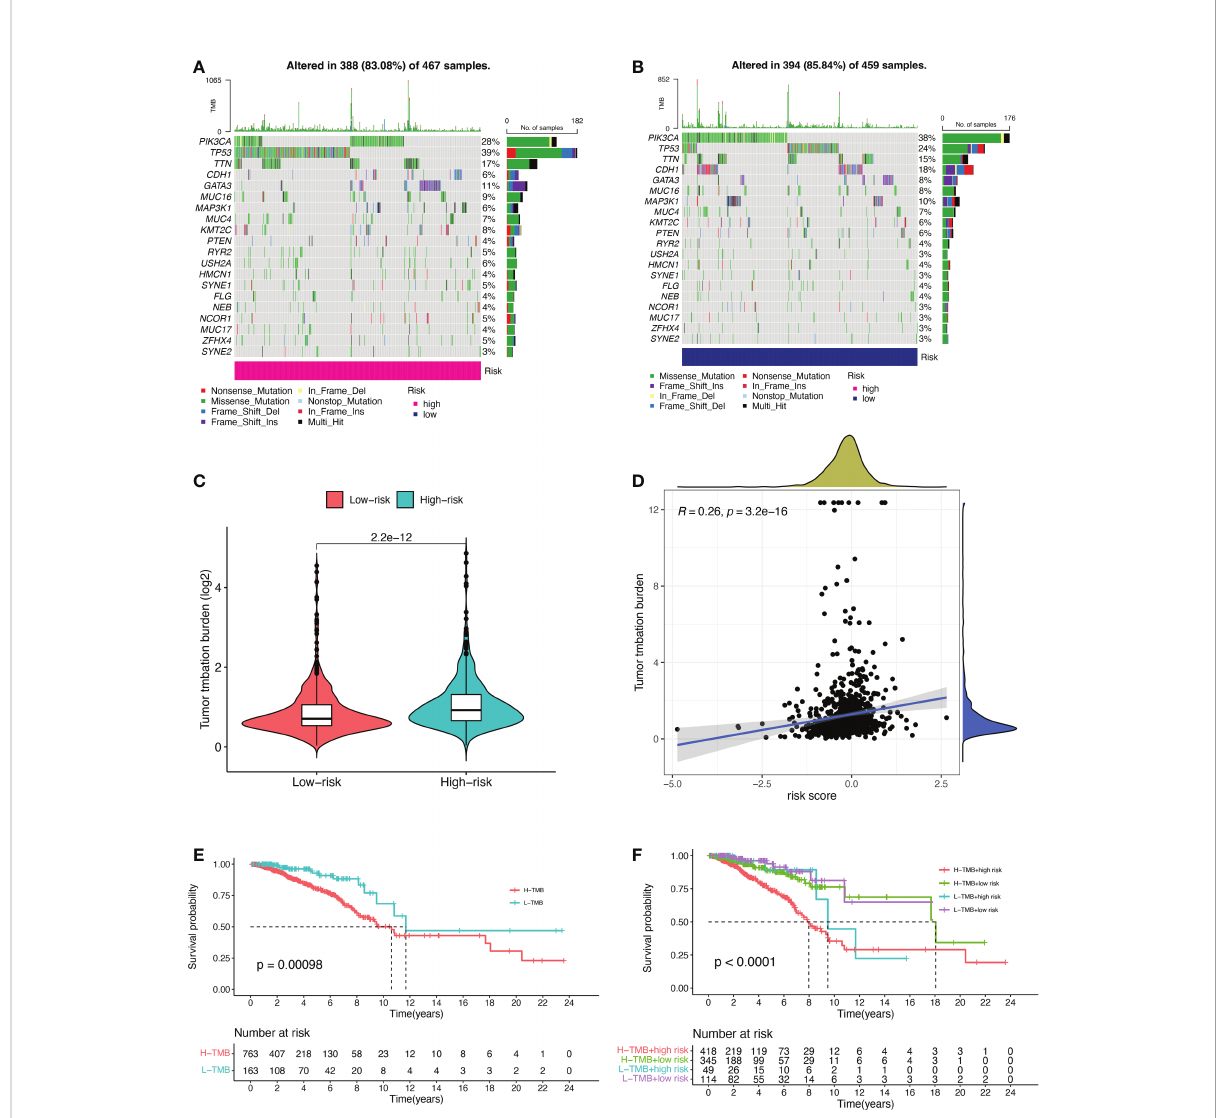
FIGURE 5 Tumor mutational burden (TMB) for prognostic features. (A, B) Waterfall plots of TMB in BC patients in the high-risk group (A) and low-risk group (B) . (C) Comparison of TMB between the high-risk and low-risk groups. (D) Correlation curves between TMB and risk scores. (E) Strati fi ed survival curves of TMB in BC patients. (F) Survival curves for BC patients in terms of L-TMB + low risk, L-TMB + high risk, H-TMB + low risk, and H-TMB + high risk. H, high; L,